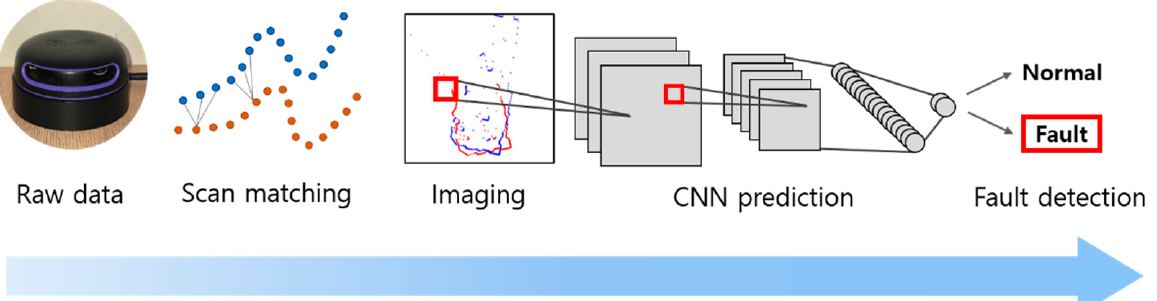
Figure 2. The concept overview of the proposed method. As soon as the raw scan data are received, the process of scan matching, the generation of images of matched scans, and fault detection are performed sequentially in each time step .